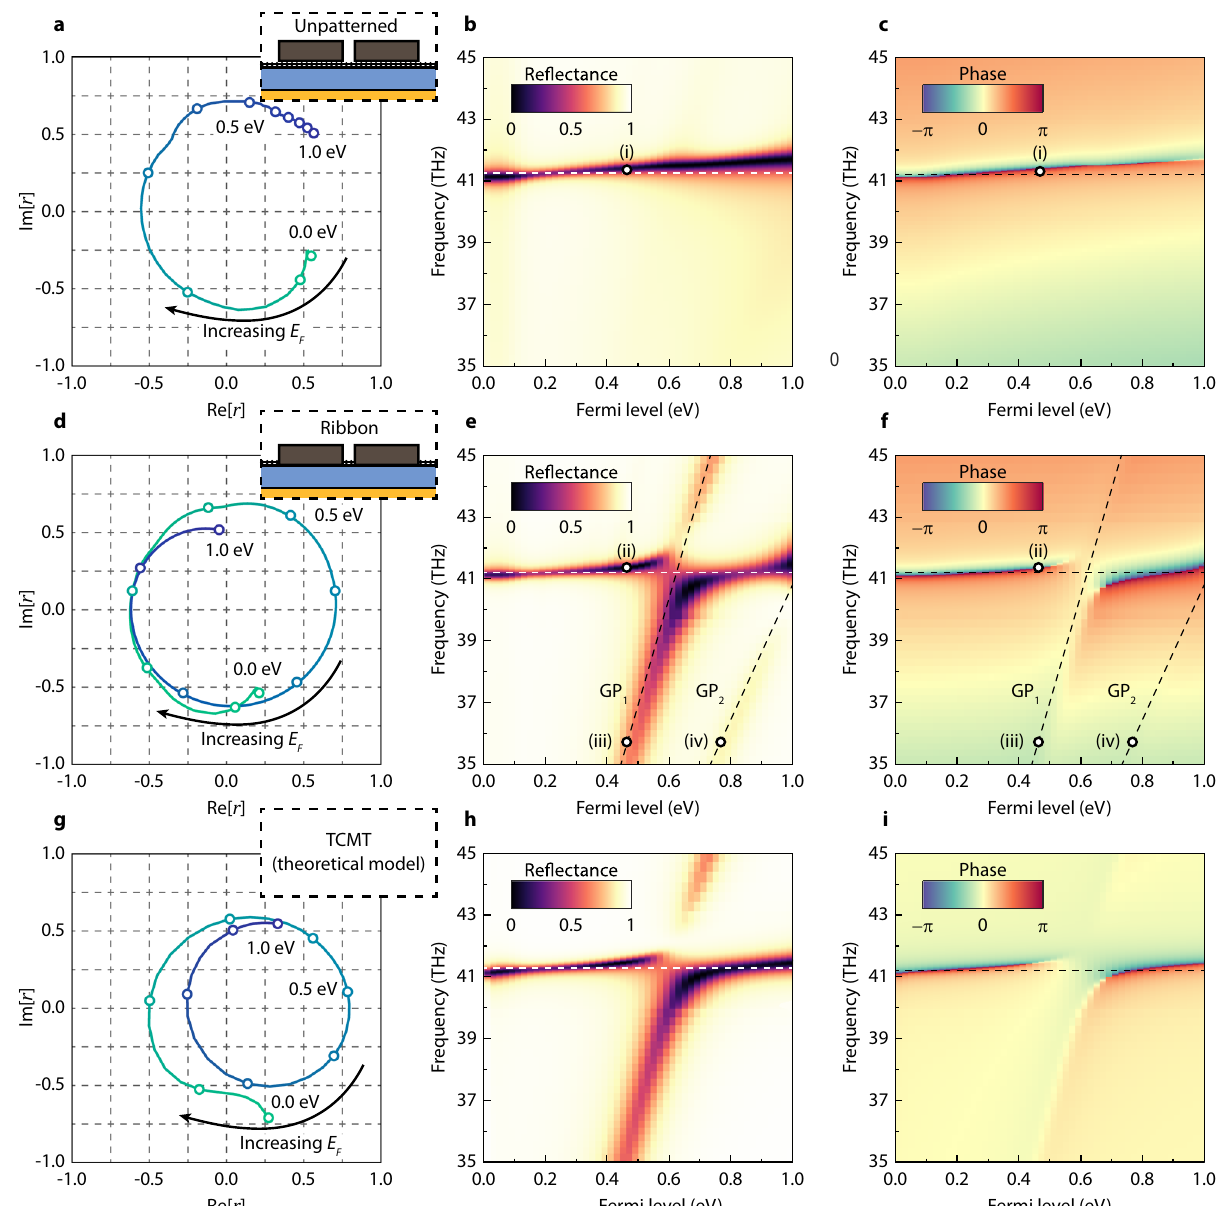
Fig. 3 Phase modulation and the dynamics involved. Full-wave calculations of the dependence of re fl ected light on E F for a dimerized Si grating on a a – c continuous sheet of graphene and d – f separated by parallel graphene nanoribbons of widths 36.7 nm (center) and 319.7 nm (side) as shown in the device structures schematically illustrated in the insets. g – i illustrate the results of the TCMT model described in the text. Panels a , d , g , show the complex re fl ection coef fi cients at 41.27, 41.20, and 41.27 THz, respectively, as E F is varied from 0 to 1 eV. Open circles throughout the curves indicate Fermi levels spaced out by 0.1 eV, starting from 0 eV. b , e , h , and c , f , i , plot the frequency dependence of the re fl ected intensity and phase, respectively.